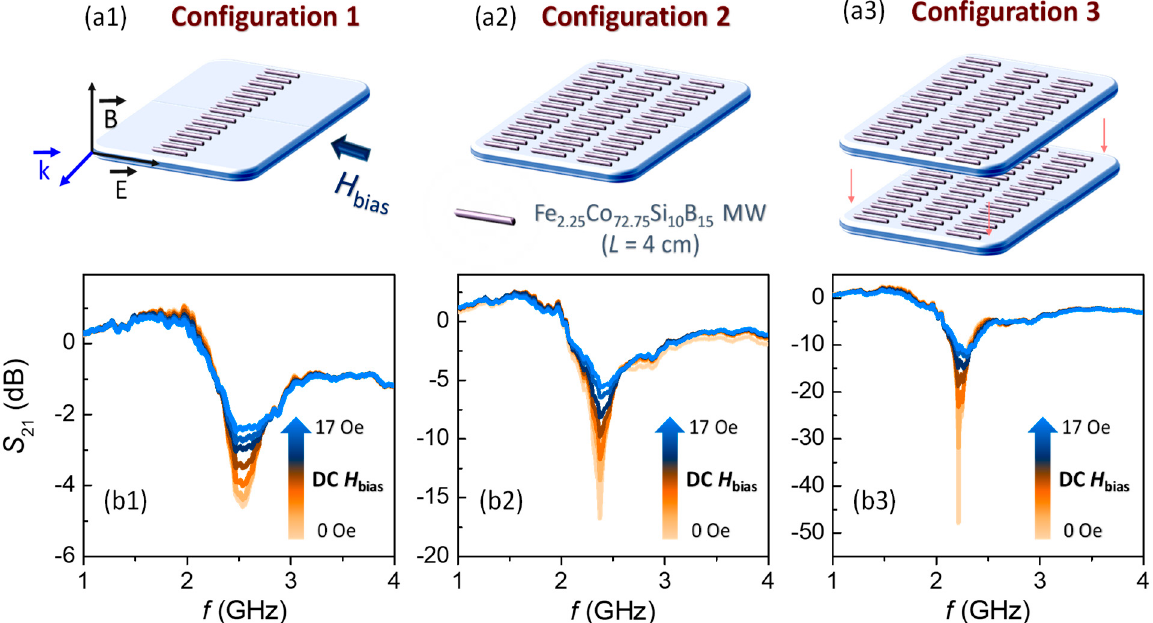
Figure 4. Effect of an external DC magnetic field with increasing value up to 17 Oe in the microwave scattering spectrum: ( a1 – a3 ) schematic illustration of MWs configurations and ( b1 – b3 ) S 21 transmission coefficient obtained for the configurations 1, 2, and 3.